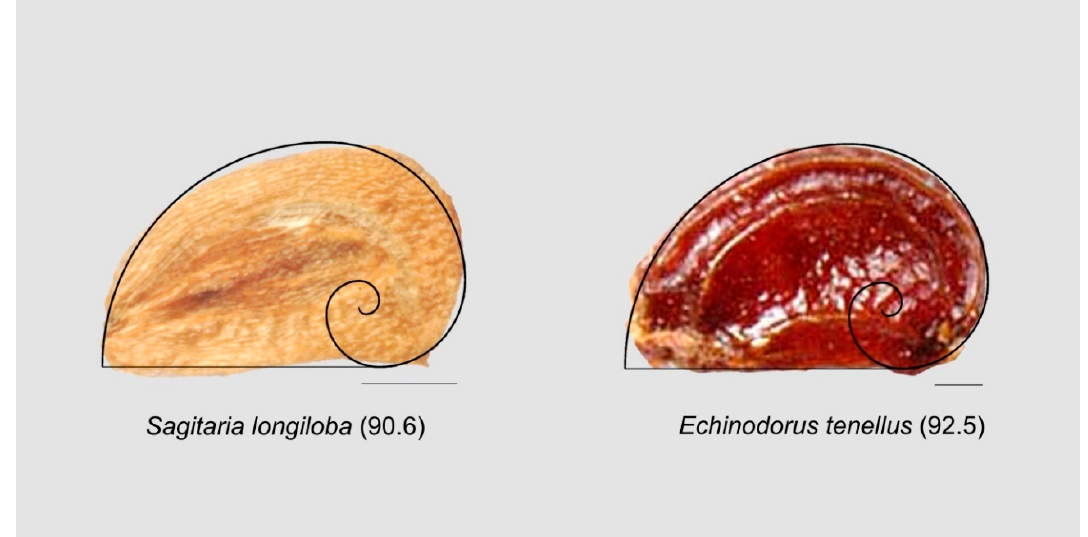
Figure 19. Seeds resembling the contour of Fibonacci’s spiral in species of the Alismataceae. The values indicated correspond to J index in the images shown and do not represent mean values for each particular species. Bar equals 0.5 mm.